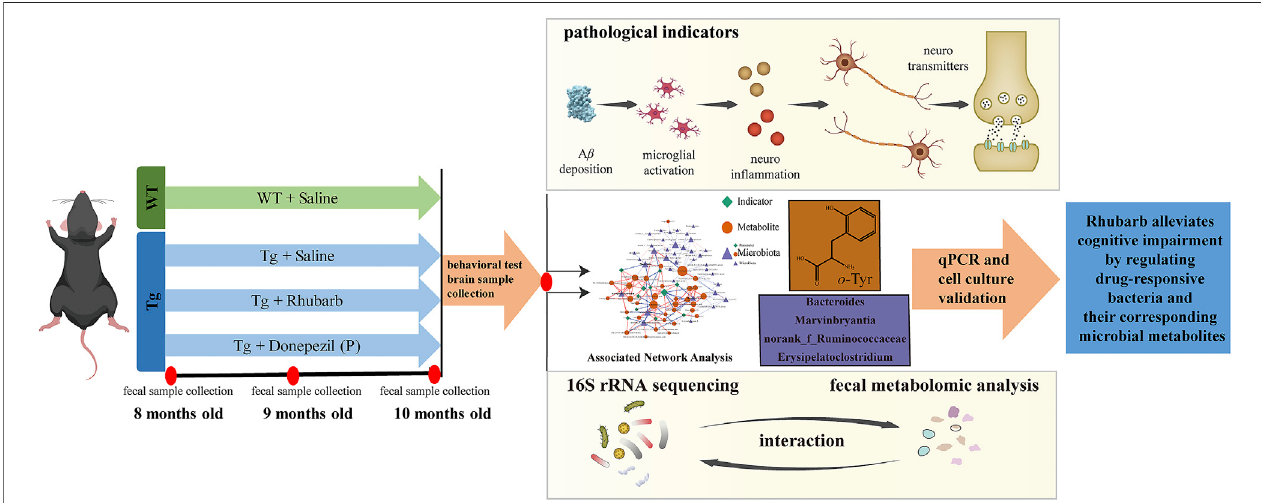
FIGURE 1 | The main content of this